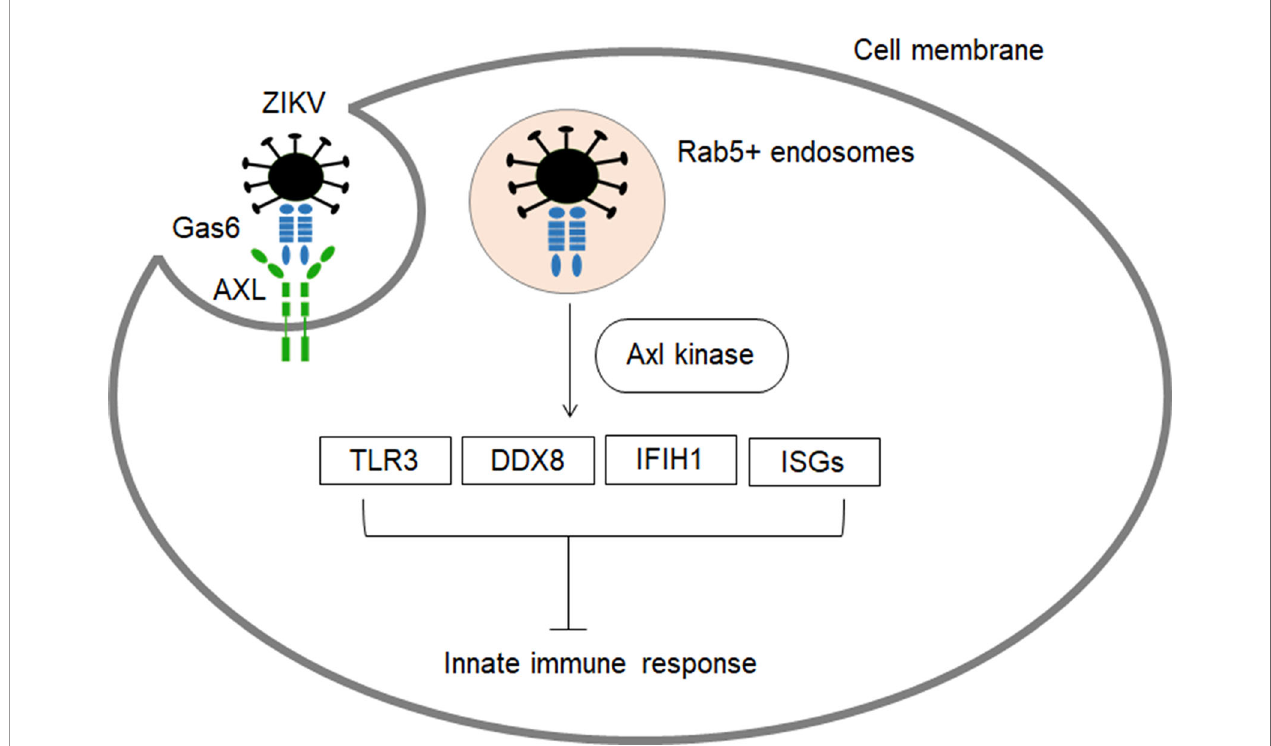
FIGURE 2 | The role of AXL receptor in ZIKV entry and subsequent inhibition of innate immune response. AXL are highly expressed in developing human brain cells (radial glia, astrocytes, endothelial and microglia), making these cell types particularly vulnerable to ZIKV infection (8, 52). ZIKV binds to Gas6 and uses Axl to gain entry into cells (53). Subsequently, the virus dampens innate immunity through activation of Axl kinase which induces the transcription of TLR3, DDX58, and IFIH1 as well as several interferon-stimulated ISGs (53,